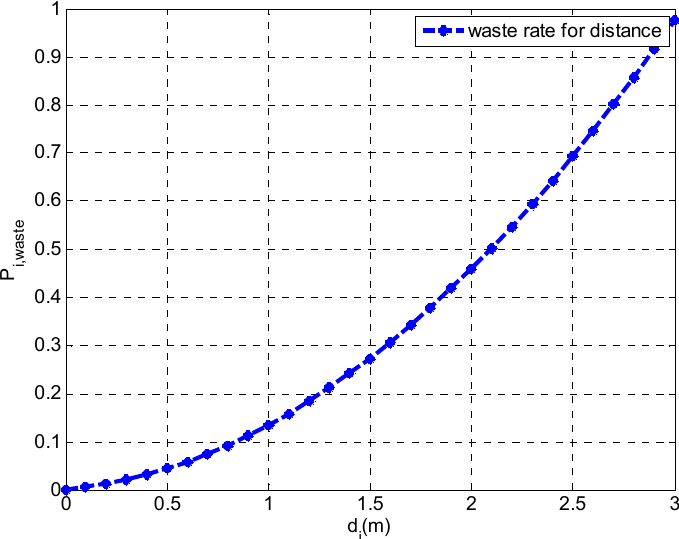
Figure 7. Energy waste rate varying with the distance.